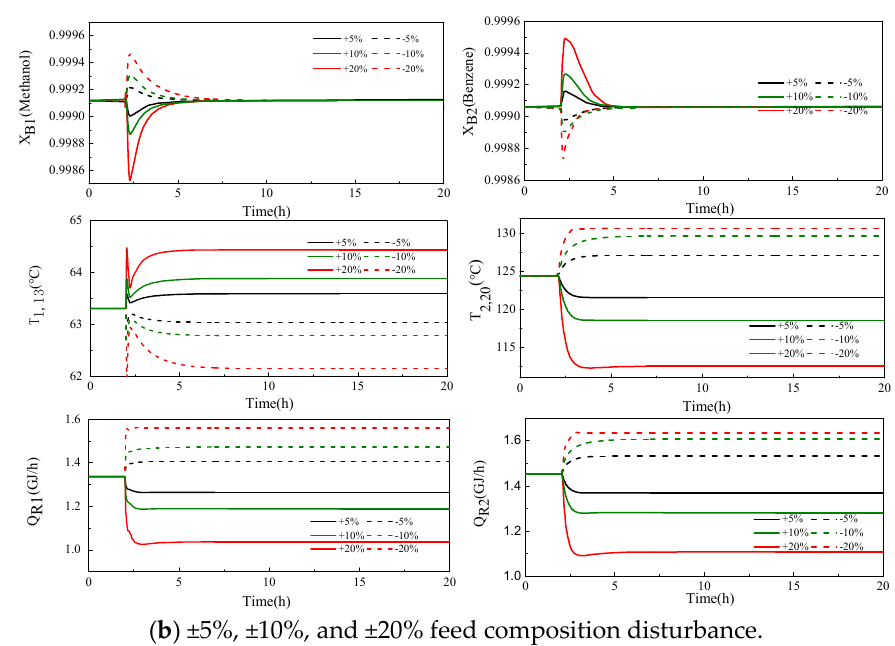
Figure 15. The dynamic responses of composition/temperature cascade control structure.